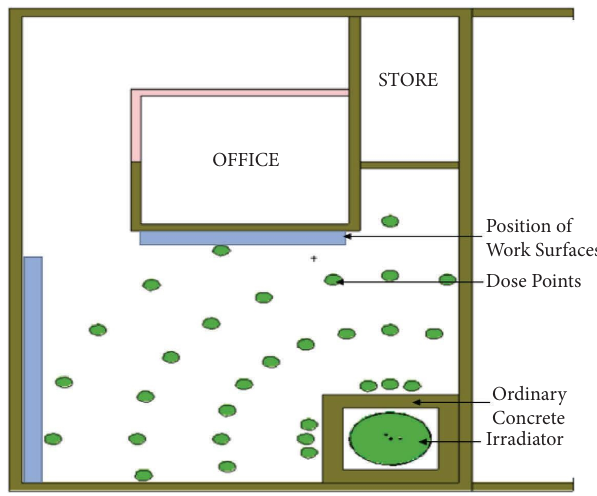
Figure 4: MCNP5 model of 241 Am-Be facility with ordinary concrete as shield.